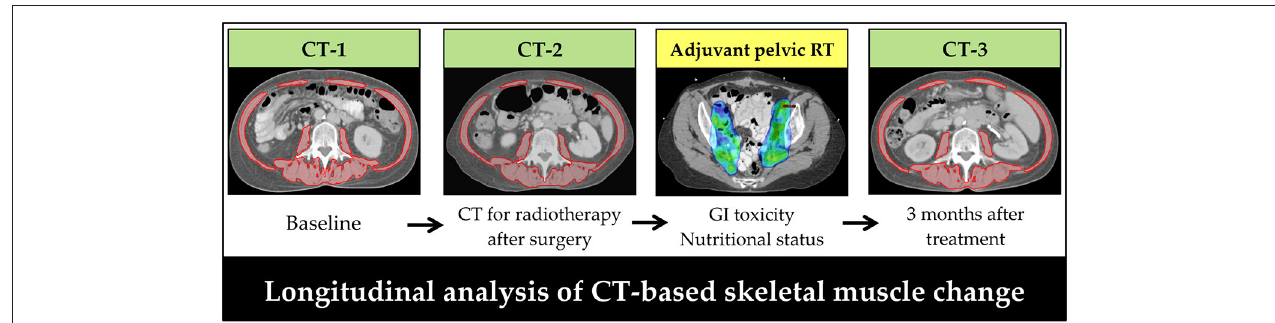
FIGURE 2 | Timeline of computed tomography scans for patients with early-stage cervical cancer receiving surgery and post-operative pelvic radiotherapy. Skeletal muscle was assessed on a transversal computed tomography slice at the level of L3. Red: skeletal muscle area. CT, computed tomography; RT, radiotherapy.